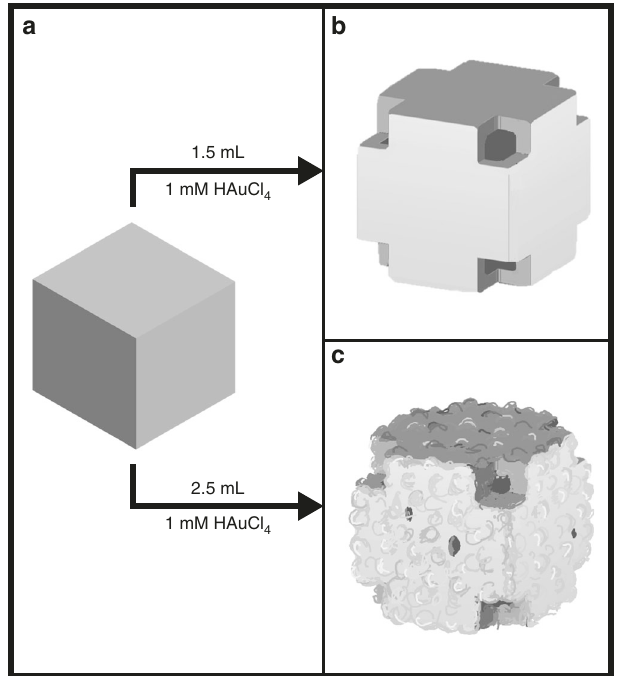
Fig. 1 Schematic of nanobox synthesis. a Galvanic replacement of a solid Ag nanocube results in b a smooth Au – Ag hollow nanobox when a low concentration of HAuCl 4 is used, and c a rough Au – Ag hollow nanobox when a low concentration of HAuCl 4 is